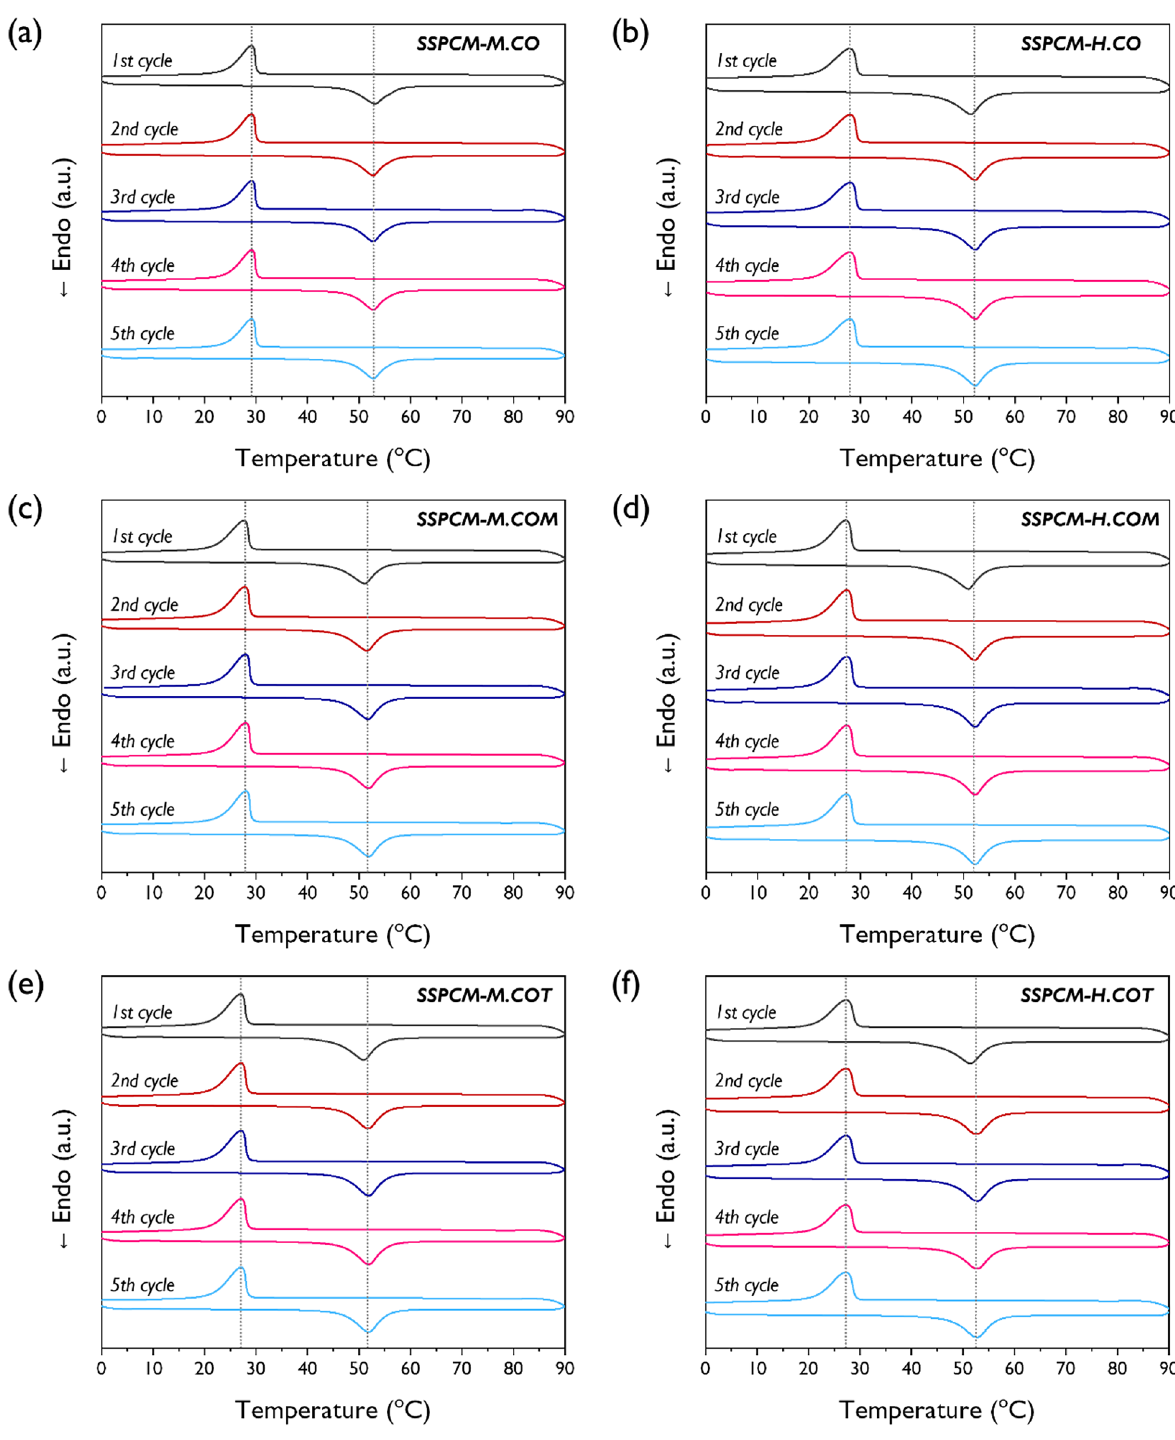
Figure 5. DSC curves of the SSPCMs with 5 consecutive heating–cooling cycles; ( a ) M.CO, ( b ) M.COM, ( c ) M.COT, ( d ) H.CO, ( e ) H.COM, and ( f )